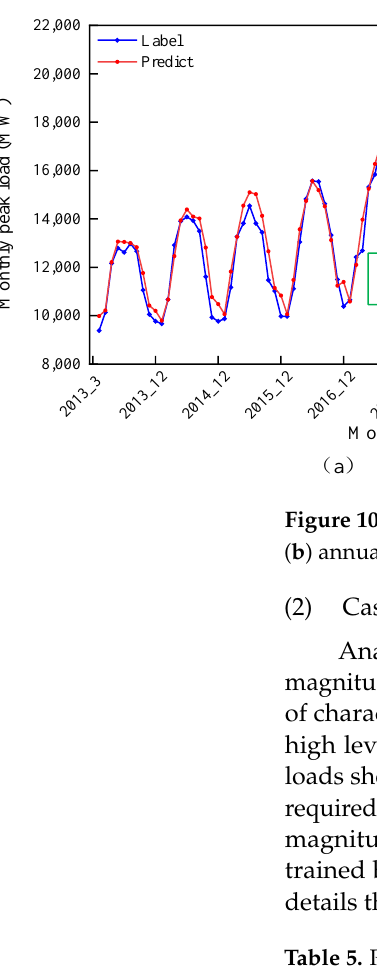
Table 5. Predictive performance of the proposed model trained based on monthly data from April to October with various time-series